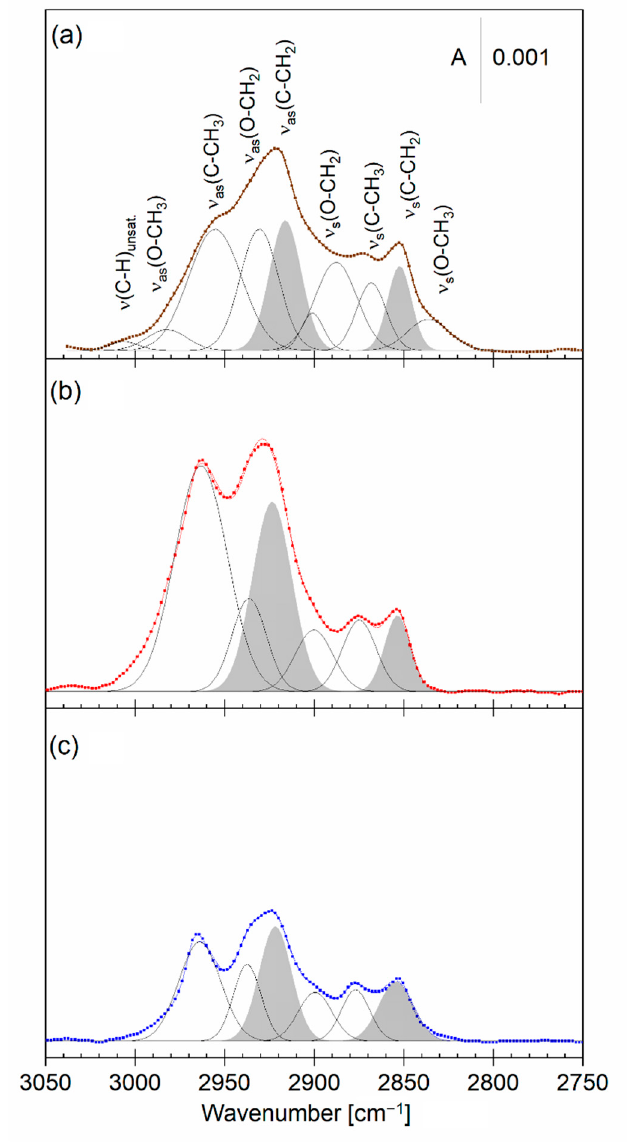
Figure 4. ( a ) Deconvoluted ATR IR spectrum (brown line) of a dried Piptoporus betulinus extract with assignment of the deconvoluted bands and ( b , c ) deconvoluted PM IRRA spectra (red and blue lines) of the asymmetric DMPC:chol—DMPC:GD 1a :chol bilayer on the Au surface transferred from ( b ) 1% vol Piptoporus betulinus extract in the aqueous subphase (red) and ( c ) aqueous subphase (blue) and in the CH stretching modes region. A—absorbance.